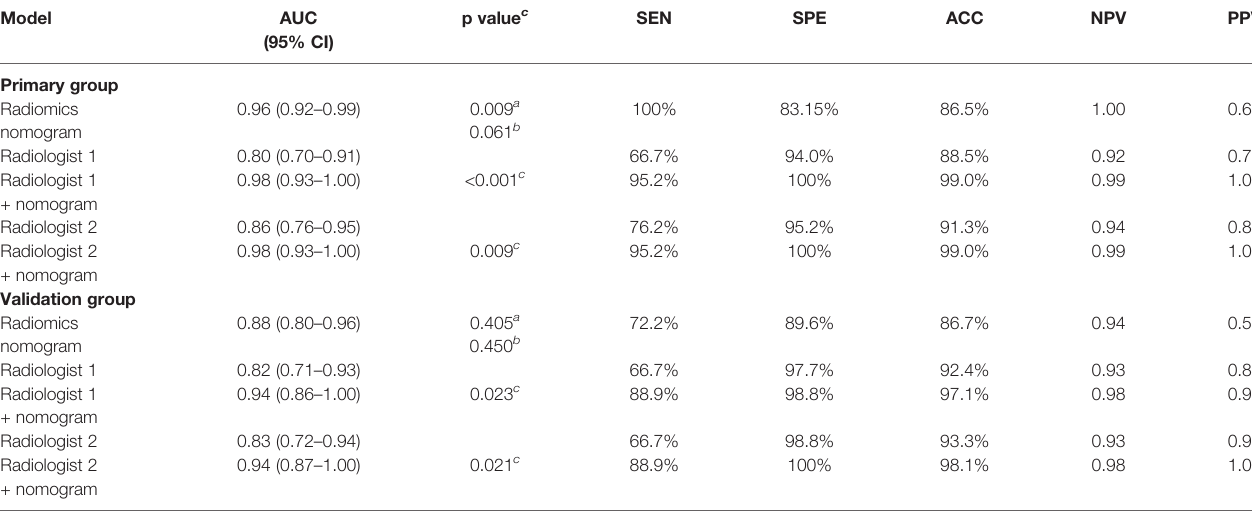
TABLE 4 | The diagnostic performance of the radiologists without and with the aid of the nomogram in the primary and validation groups. Model AUC p value c